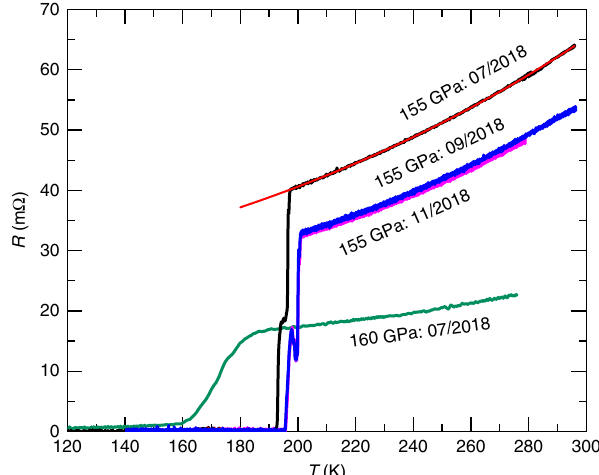
Fig. 1 Resistive transition towards the superconducting state. Resistance R as a function of the temperature T for two DACs containing H 3 S samples under pressures p = 155 GPa and 160 GPa. Red line is a fi t to R = R 0 + AT 2 . Notice that the T c for the 155 GPa sample shifts slightly to higher values while its resistance decreases between July and September 2018. Source data are provided as a Source Data fi